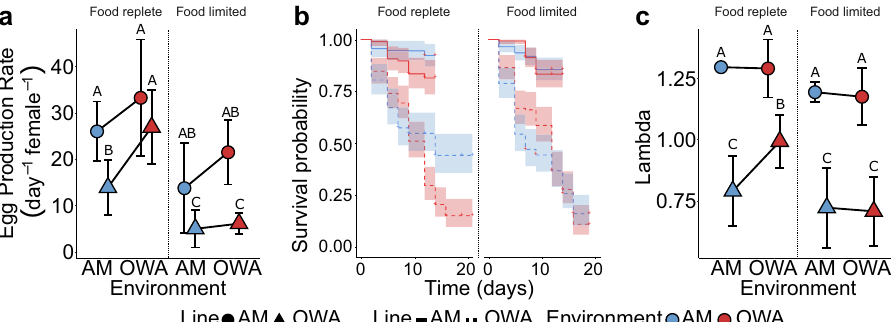
Fig. 6 Life-history traits after 20 generations of selection in ambient (AM) and warming and acidi fi cation (OWA) conditions and one generation of reciprocal transplant. For all panels, shape indicates selection line, color indicates environmental condition. Data are presented as mean values and error bars represent 95% con fi dence intervals. a Egg production rate under ad-libitum and food-limited conditions ( n = 6 – 12 independent mate pairs per food condition per treatment). b Survivorship under ad-libitum and food-limited conditions ( n = 3 – 4 independent experiments per food condition per treatment). c Lambda (net reproductive rate) calculated from combined fecundity, development rate, sex ratio, and survivorship data where a values >1 indicate positive growth ( n = 24 – 28 independent estimates per treatment per food condition). Capital letters in a and c represent statistically separate groups ( P < 0.05) from two-way anovas with a post hoc two-sided t -test to correct for multiple testing. Groups with multiple letters are included in multiple statistical groups. Source data are provided as a Source Data fi